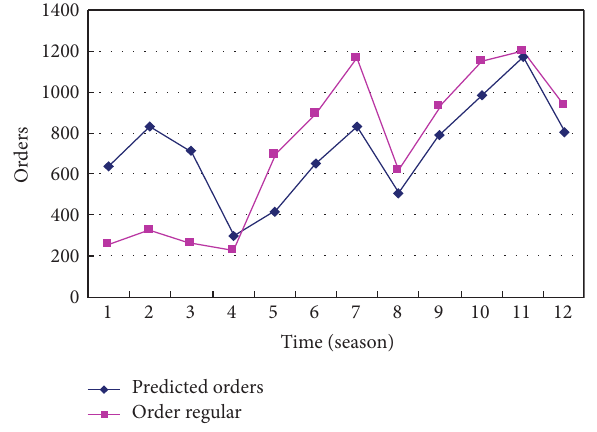
Figure 6: Binary linear regression: regular orders and import & export and